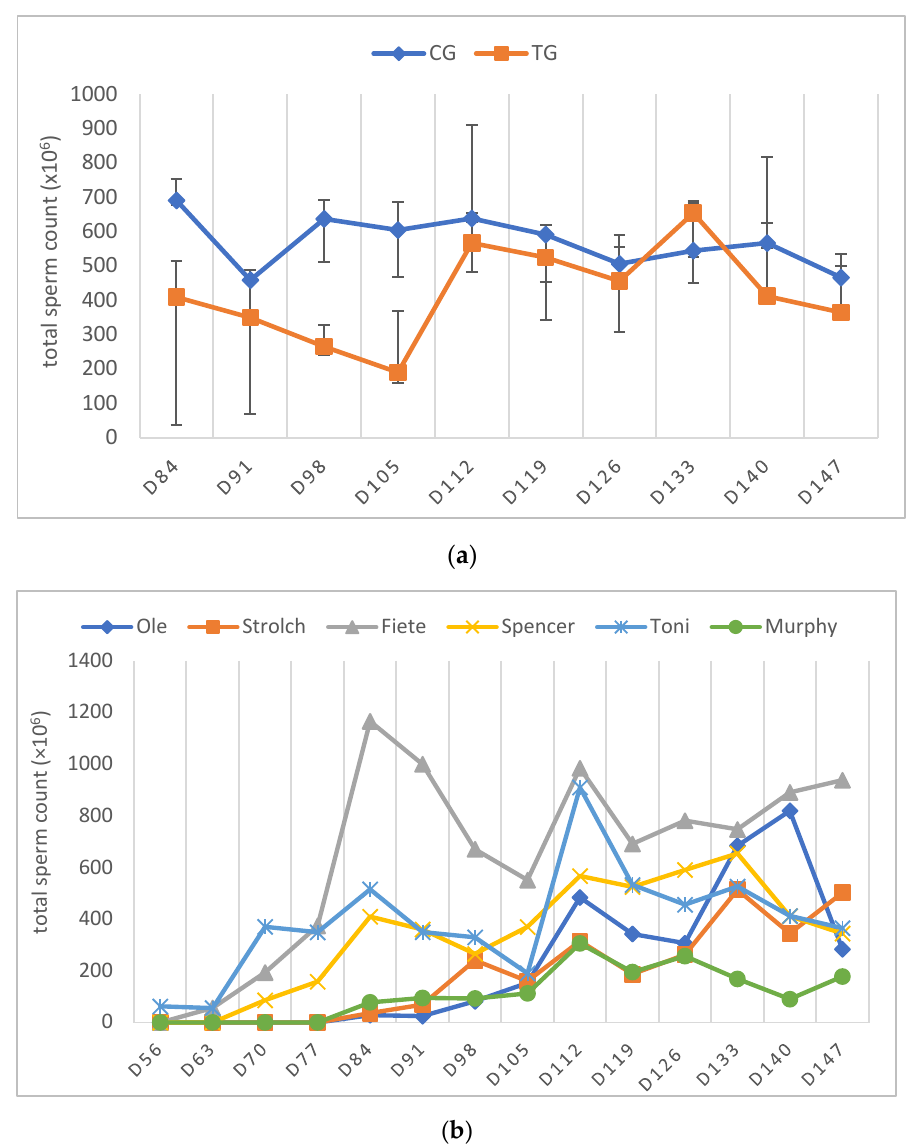
Figure 8. ( a ) Total sperm count (×10 6 ) over time given as median (Q1, Q3) of animals treated with a 4.7 mg deslorelin implant (TG, n = 5, excluding Murphy) and saline-treated control animals (CG, n = 3). ( b ) Total sperm count (×10 6 ) given as individual courses of animals treated with a 4.7 mg deslorelin implant (TG, n = 6).